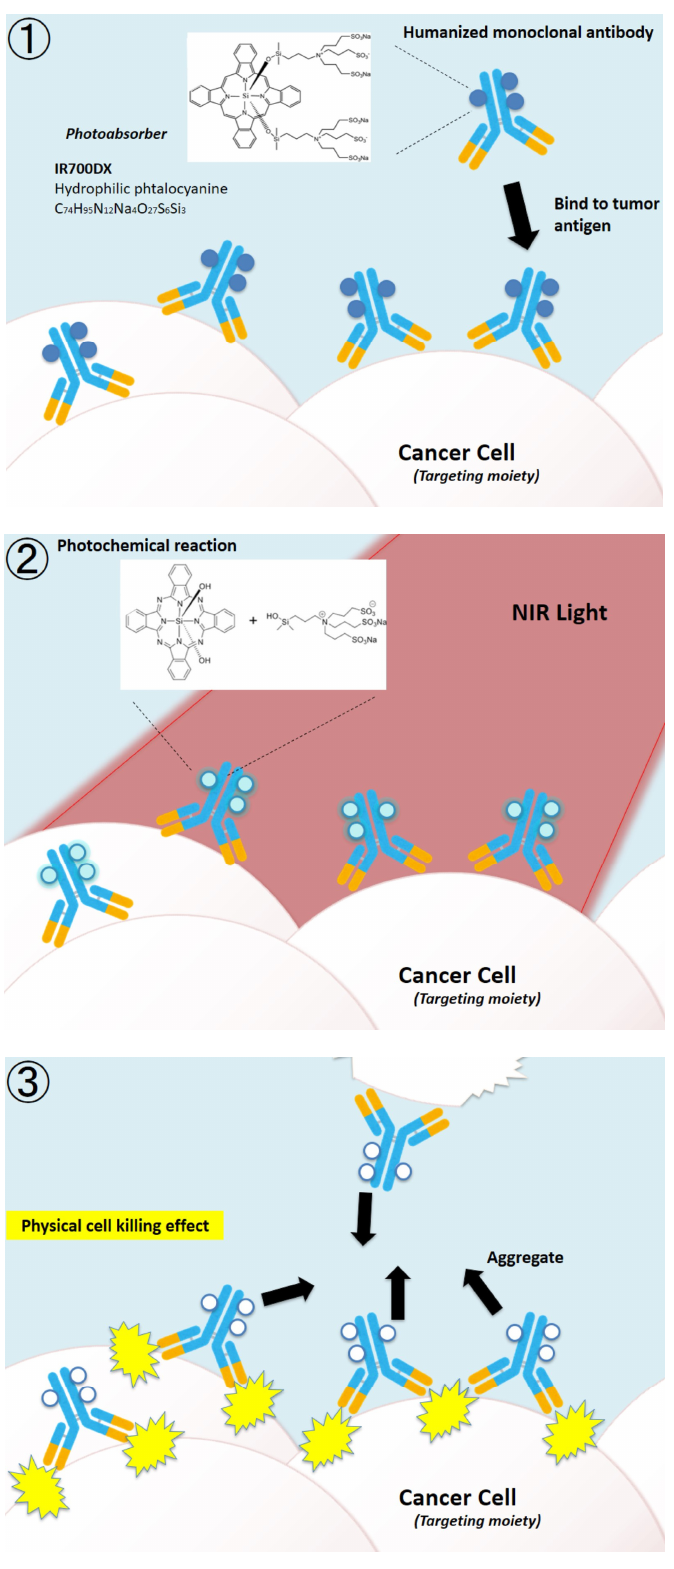
Figure 1. Schematic representation of near-infrared photoimmunotherapy. The conjugates, consisting of humanized monoclonal antibody and photo absorber IR700DX, can target specific cancer cell antigens. Once NIR-light irradiates, the targeting cancer cells are